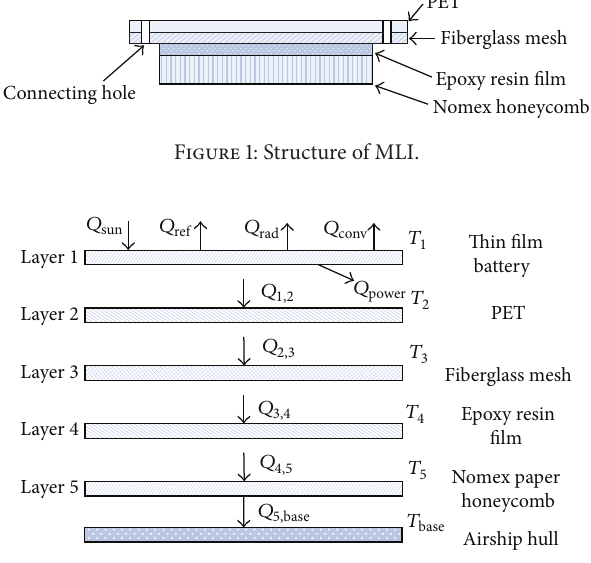
Figure 2: MLI heat transfer